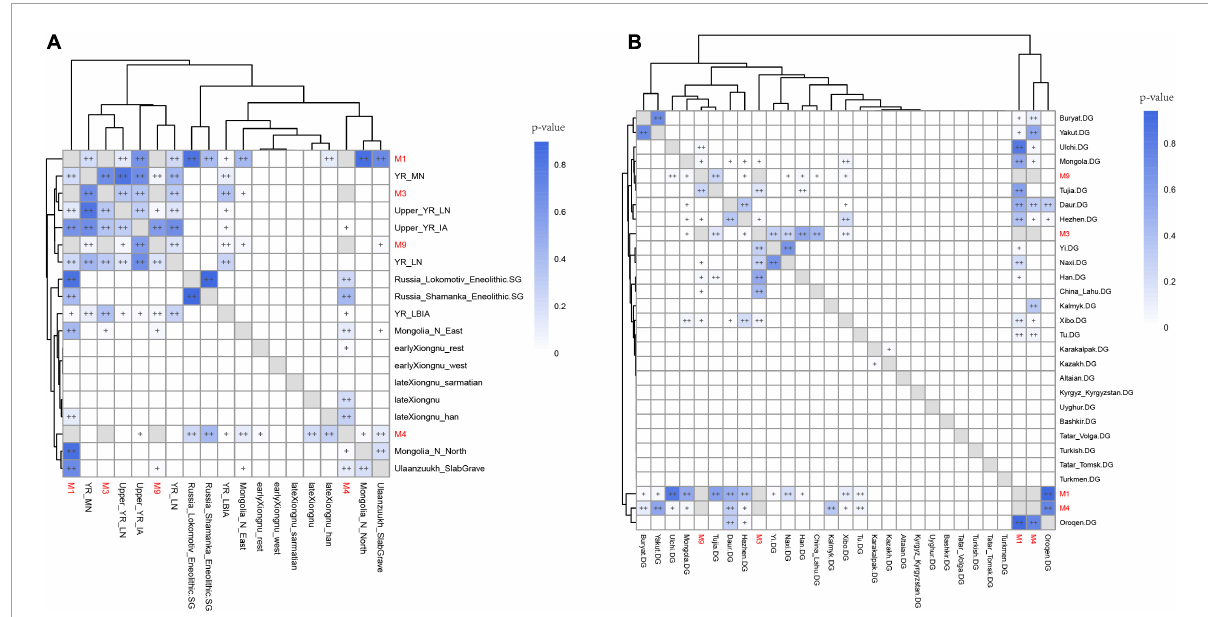
FIGURE6 The results of qpWave analysis show the different genetic affinity patterns of four Shichengzi individuals to ancient populations in the Yellow River valley (A) and Mongolia Plateau (B) . “++” represented values greater than 0.05, and “+” represented values lower than 0.05 but larger than 0.01. p > 0.05 indicated the supported genetic clade between pairs. Computations were based on the outgroup set (Mbuti.DG, Onge.DG, Yana_UP.SG, Loschbour.DG, Iran_GanjDareh_N, Turkmenistan_Gonur_BA_1, Russia_Afanasievo, Anatolia_N, Kazakhstan_Eneolithic_Botai.SG, AR19K, Liangdao2, Japan_Jomon,